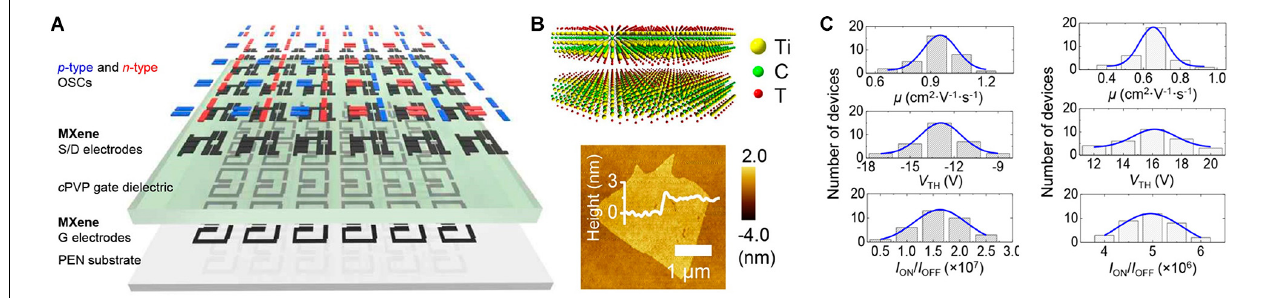
FIGURE 6 | OFETs with 2D materials as electrodes. (A) Schematic image of the OFET device array based on Ti 3 C 2 T x MXene electrodes. (B) Crystal structure of MXene (top) and AFM image of the monolayer MXene on the SiO 2 substrate (bottom). (C) Histogram and normal distribution of electrical properties of p-type pentacene OFETs with MXene electrodes (left) and n-type PTCDI-C 8 OFETs with NMX electrodes (right). Reproduced from Lyu et al. (2019) with permission from Copyright 2019 American Chemical Society.